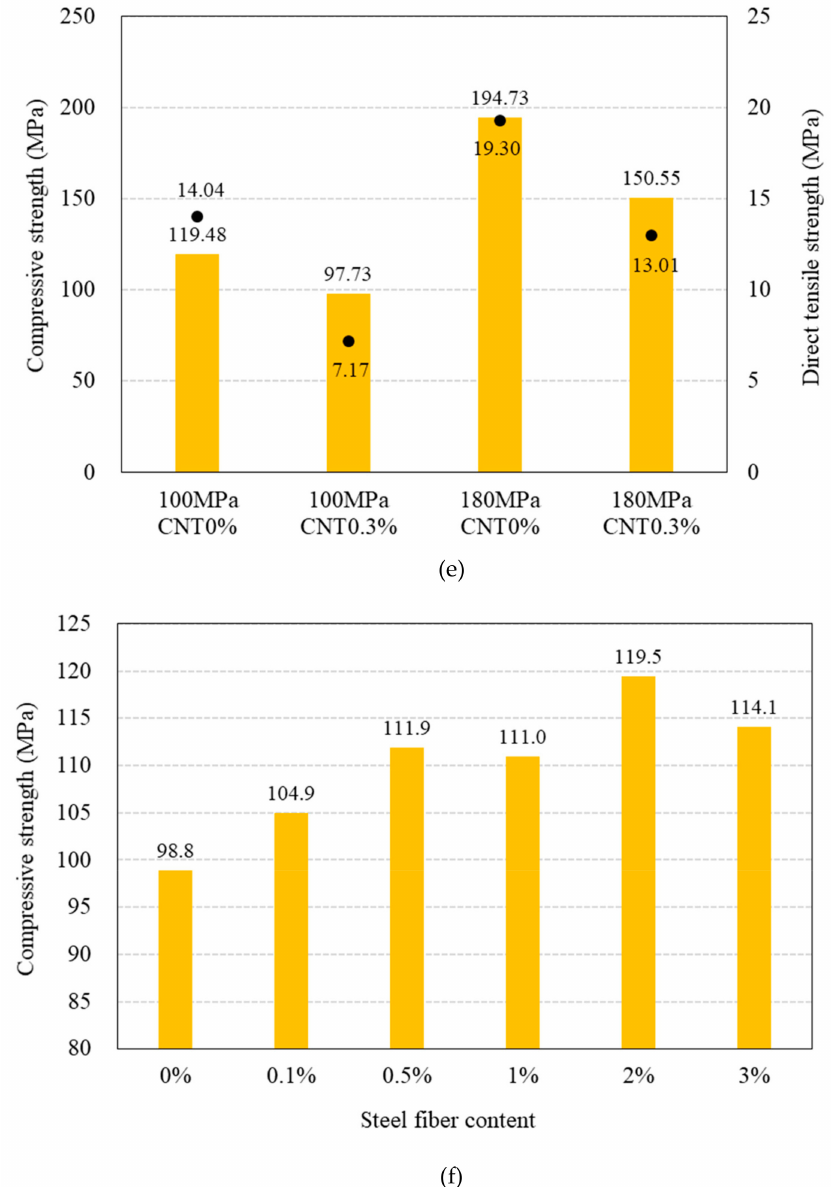
Figure 11. Compressive strength and direct tensile strength results for 100 MPa and 180 MPa-HPFRCC w / wo steel fibers. ( a ) Use of powder-type MWCNT in 100 MPa-HPFRCC without steel fiber; ( b ) use of liquid-type MWCNT solution in 100 MPa-HPFRCC without steel fiber; ( c ) use of powder-type MWCNT in 180 MPa-HPFRCC with 2.0% steel fiber; ( d ) use of powder-type MWCNT in 180 MPa-HPFRCC with 2.0% steel fiber; ( e ) use of liquid-type MWCNT in HPFRCC with 2.0% steel fiber; ( f ) steel fiber